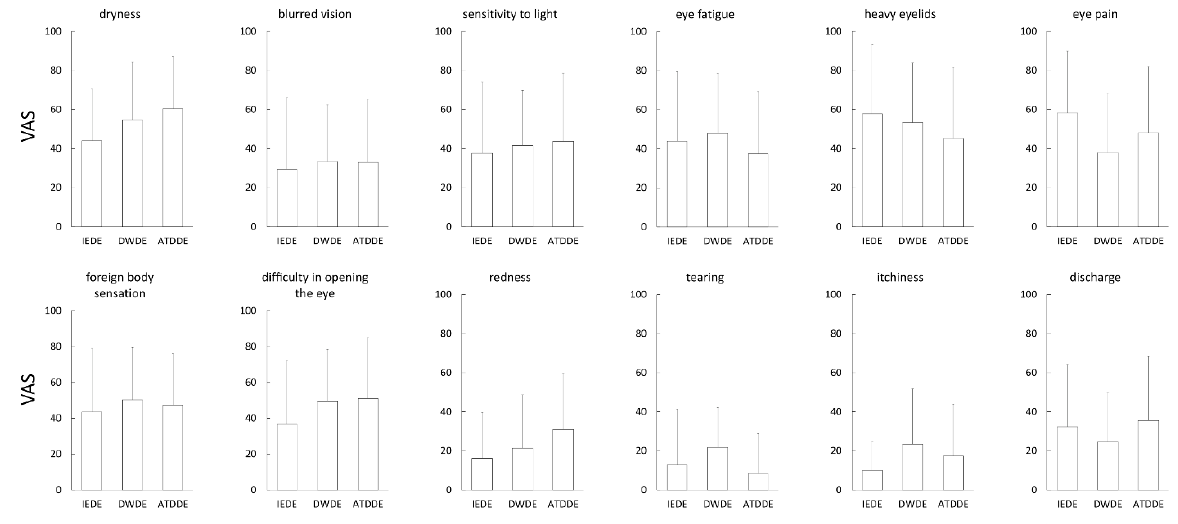
Figure 1. Dry eye (DE) related subjective symptoms evaluated by visual analog scale (VAS). The mean value of the VAS for each symptom is plotted for each DE subtype, and the standard deviation is shown as a vertical bar. The Tukey-Kramer HSD test was used for statistical analysis, and a p -value of <0.05 was considered statistically significant.